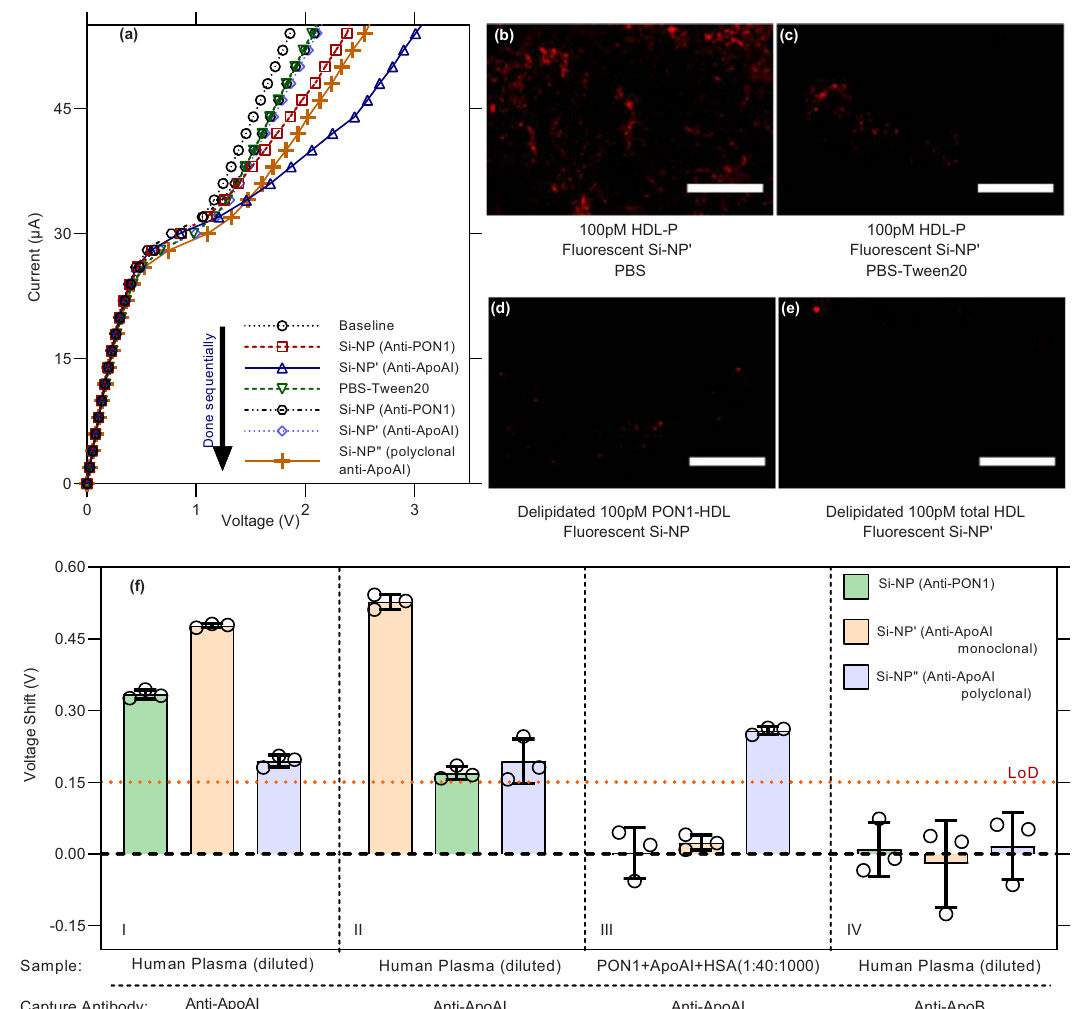
fl uorescent Si-NP, and e when predelipidated 100pM HDL-P is used followed by addition of fl uorescent Si-NP'. For both d , e , detergent treatment is done at higher HDL concentration and then diluted with PBS to achieve desired concentration. f Control experiments with 50000× diluted pooled human and plasma protein cocktails at different orders of Si-NPs, and different capture antibodies and sam- ples. Error bars represent one standard deviation and each case in f are